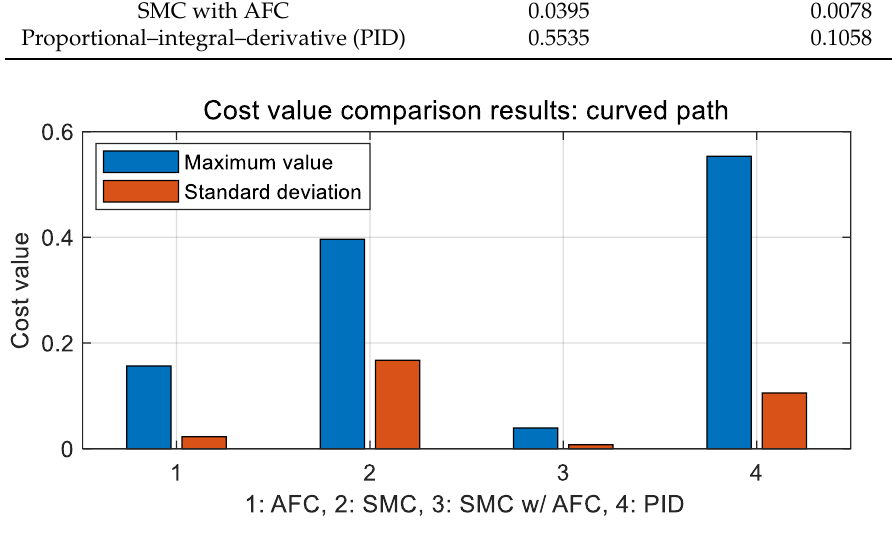
Figure 13. Results: cost value comparison in bar chart form for the curved path tracking.